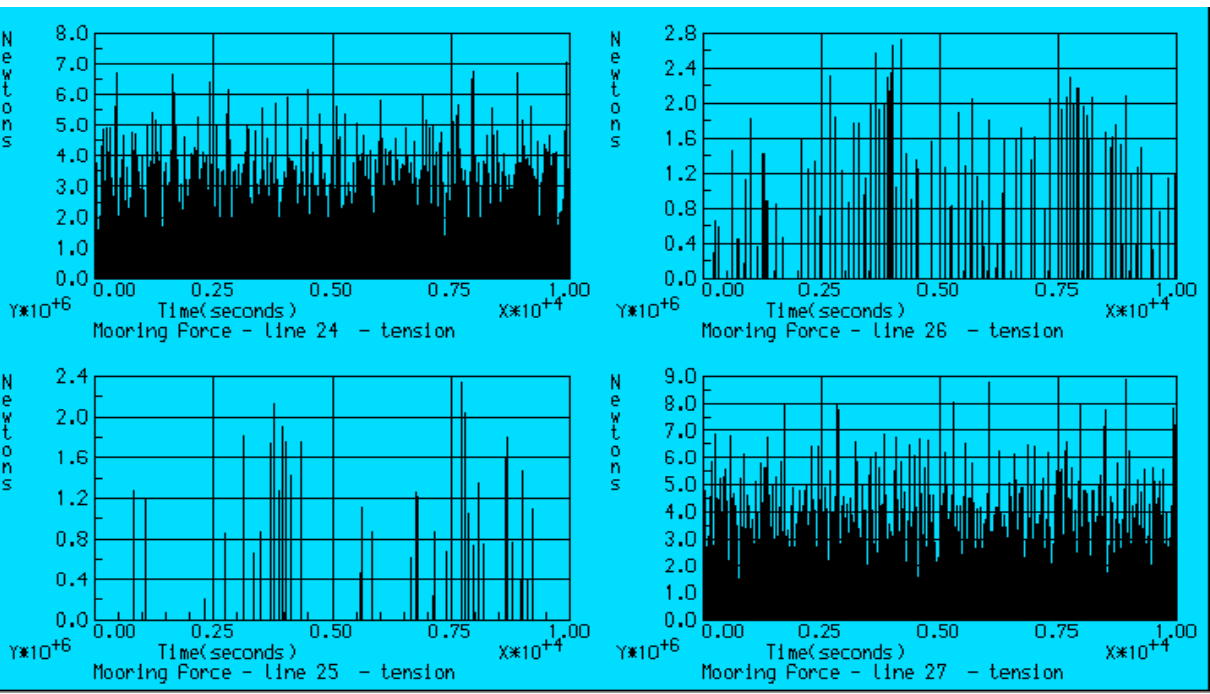
Figure 10. Load case c2—applied tension (N) on the berths’ mooring lines.